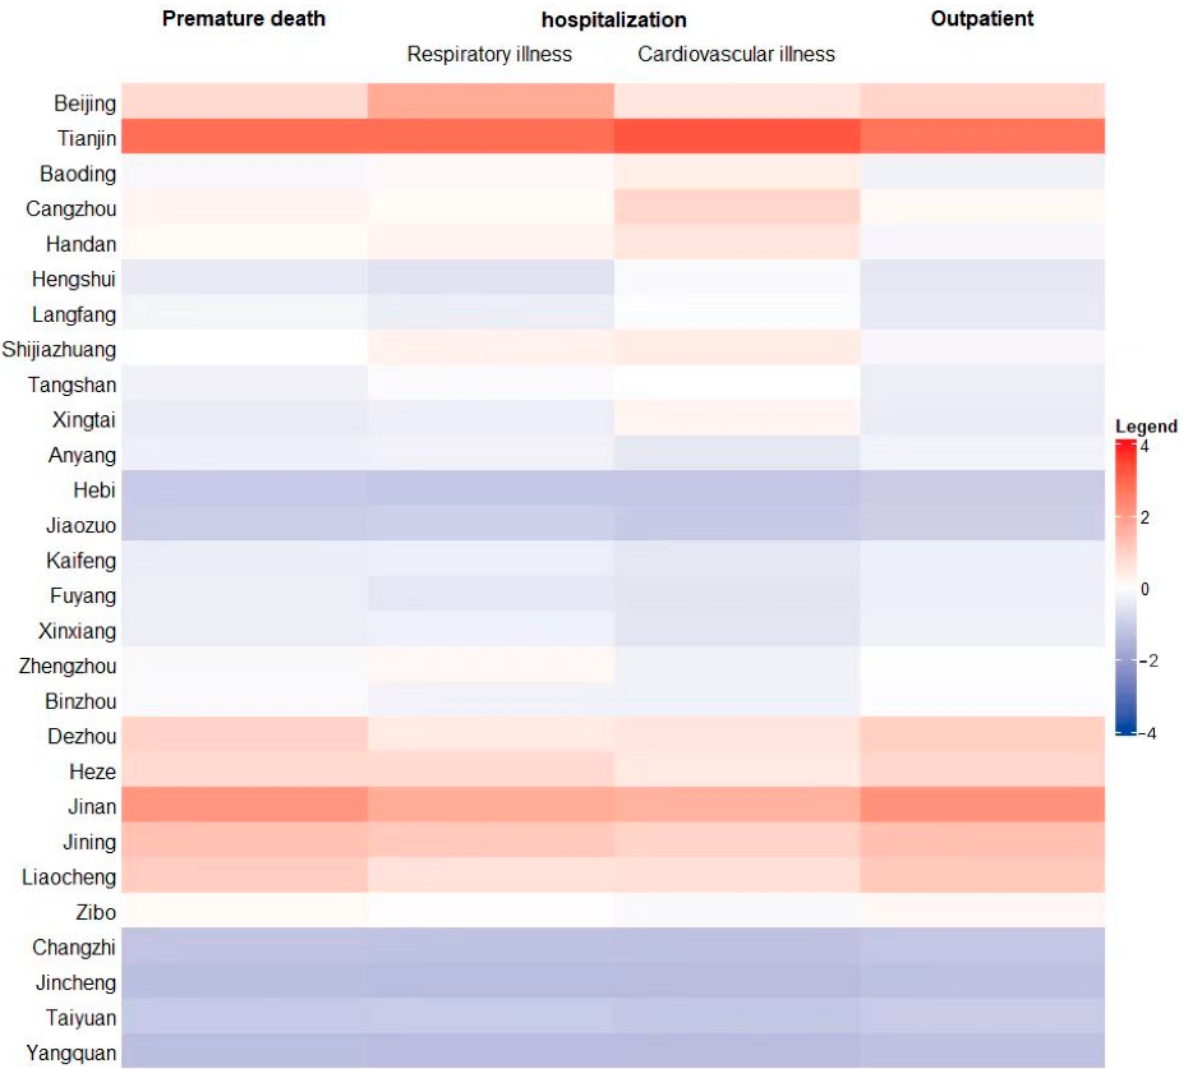
Figure 5. Normalized economic loss of three kinds of health effect terminals in 2020.